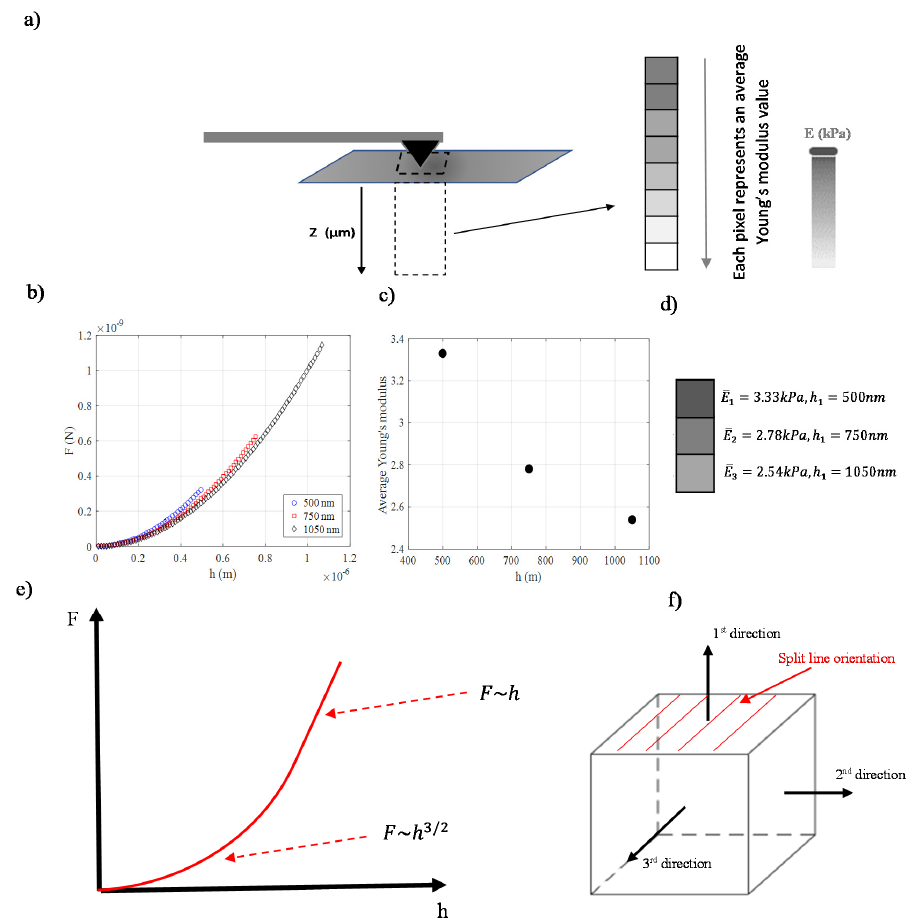
Figure 3. ( a ) Illustration of a nanoindentation experiment on a specific point. The depth-dependent mechanical properties at a specific nanoregion can be revealed by using this approach. If multiple points are tested, a depth-dependent Young’s modulus map can be created. ( b ) Three fitted curves for the same force indentation data (using Equation (9)) but for different domains (0 ≤ h ≤ 500 nm, 0 ≤ h ≤ 750 nm, 0 ≤ h ≤ 1050 nm). ( c ) The average Young’s modulus values for each domain. ( d ) Each value is represented by a colored pixel. ( e ) When using a spherical indenter on an elastic half-space the applied force is proportional to h 3/2 for small indentation depths and to h for big indentation depths. Thus, if the data are fitted to Equation (7), a ‘pseudo-softening’ behavior is recorded. ( f ) Determination of the depth-dependent anisotropy of the extracellular and pericellular matrices of articular